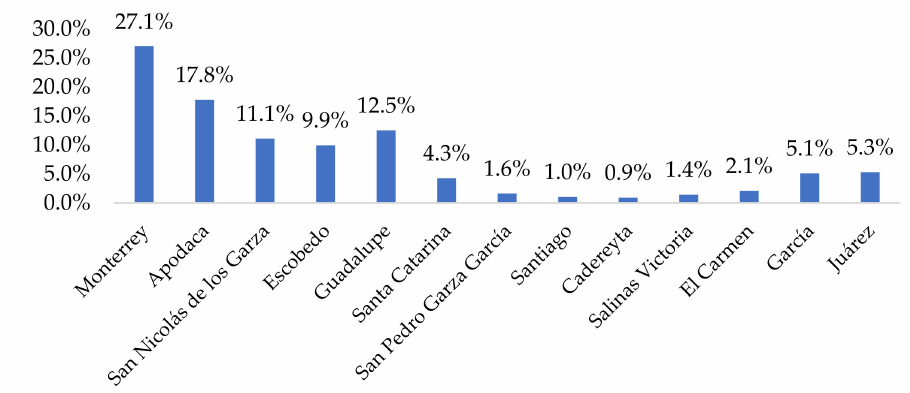
Figure 1. Percentages of participants according to the municipality that belongs to the metropolitan area of Monterrey.